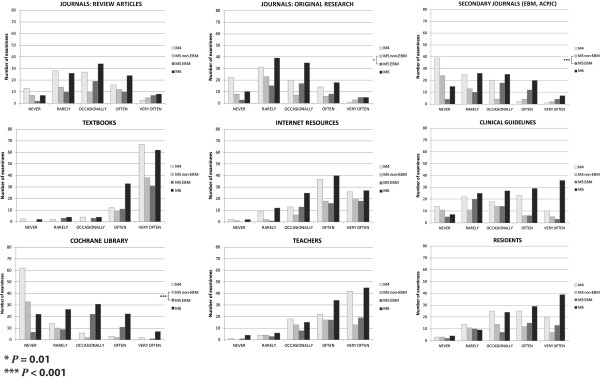
Use of evidence to solve a health problem. Distribution of answers to the question: "what type of resources do you use to solve a specific health problem?" in the different medical student groups. (M4=4th year students with no evidence-based medicine training; M5 EBM and M5 non-EBM=5th year medical students with and without the evidence-based medicine course; M6=6th year students exposed to the evidence-based medicine course during the year prior to assessment; EBM=Evidence-Based Medicine; ACPJC=American College of Physicians Journal Club). * =P<0.01 Mann–Whitney U test for the M5 vs. M5 non-EBM comparison.*** = P<0.001 Mann–Whitney U test for the M5 vs. M5 non-EBM comparison.